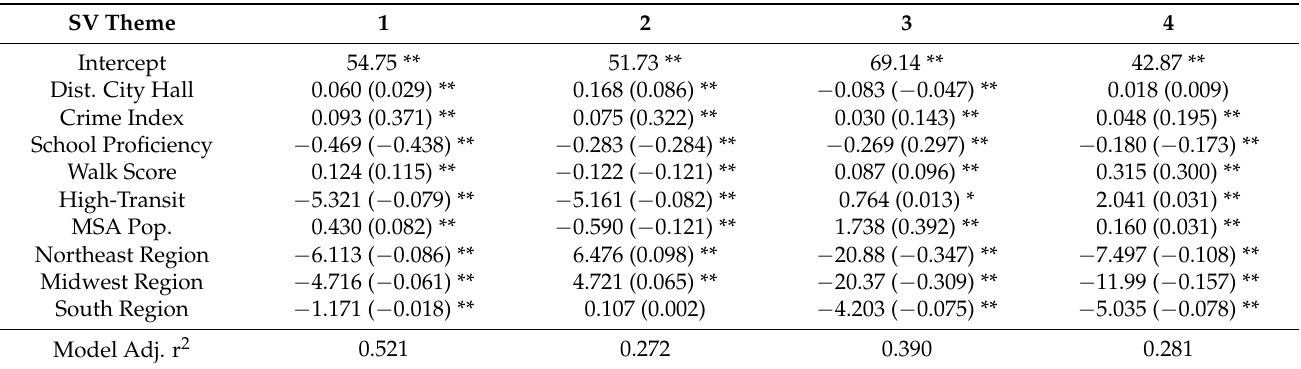
Table 2. Regression results with the four constituent social vulnerability (SV) themes as dependent